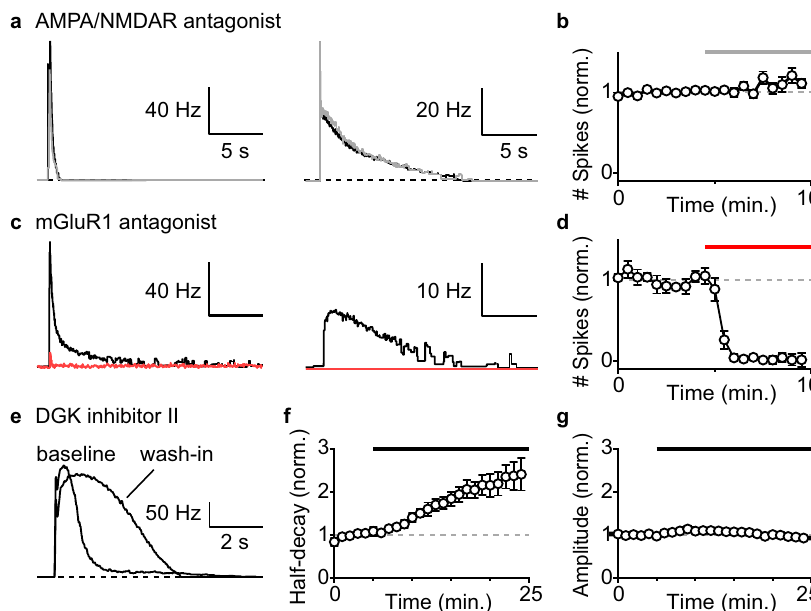
Fig. 3 mGluR1 and DGK control excitatory mossy fi ber responses in UBCs. a Examples of instantaneous fi ring rate from on-cell recordings before (black) and after (gray) the application of AMPA/NMDA receptor antagonist (gray bar) in a fast (left) and a slow (right) UBC. Each trace is an average of 8 trials. b Summary of evoked spiking (20 × 100 Hz) and the effect of AMPA/NMDA receptor antagonist (normalized to baseline, mean ± sem, n = 5). c Examples of instantaneous fi ring rate from on-cell recordings before (black) and after (red) the application of an mGluR1 antagonist (red bar) in a fast (left) and a slow (right) UBC. Each trace is an average of 8 trials. d Summary of evoked spiking (20 × 100 Hz) and the effect of an mGluR1 antagonist (normalized to baseline, mean±sem, n = 5). e Example of instantaneous fi ring rate before and after 20 minutes of DGK inhibitor II wash-in. f Summary of half-decay time of instantaneous fi ring rate response with DGK inhibitor II (normalized to baseline, mean ± sem, n = 6). g Summary of peak amplitude of instantaneous fi ring rate response with DGK inhibitor II (normalized to baseline, mean±sem, n =